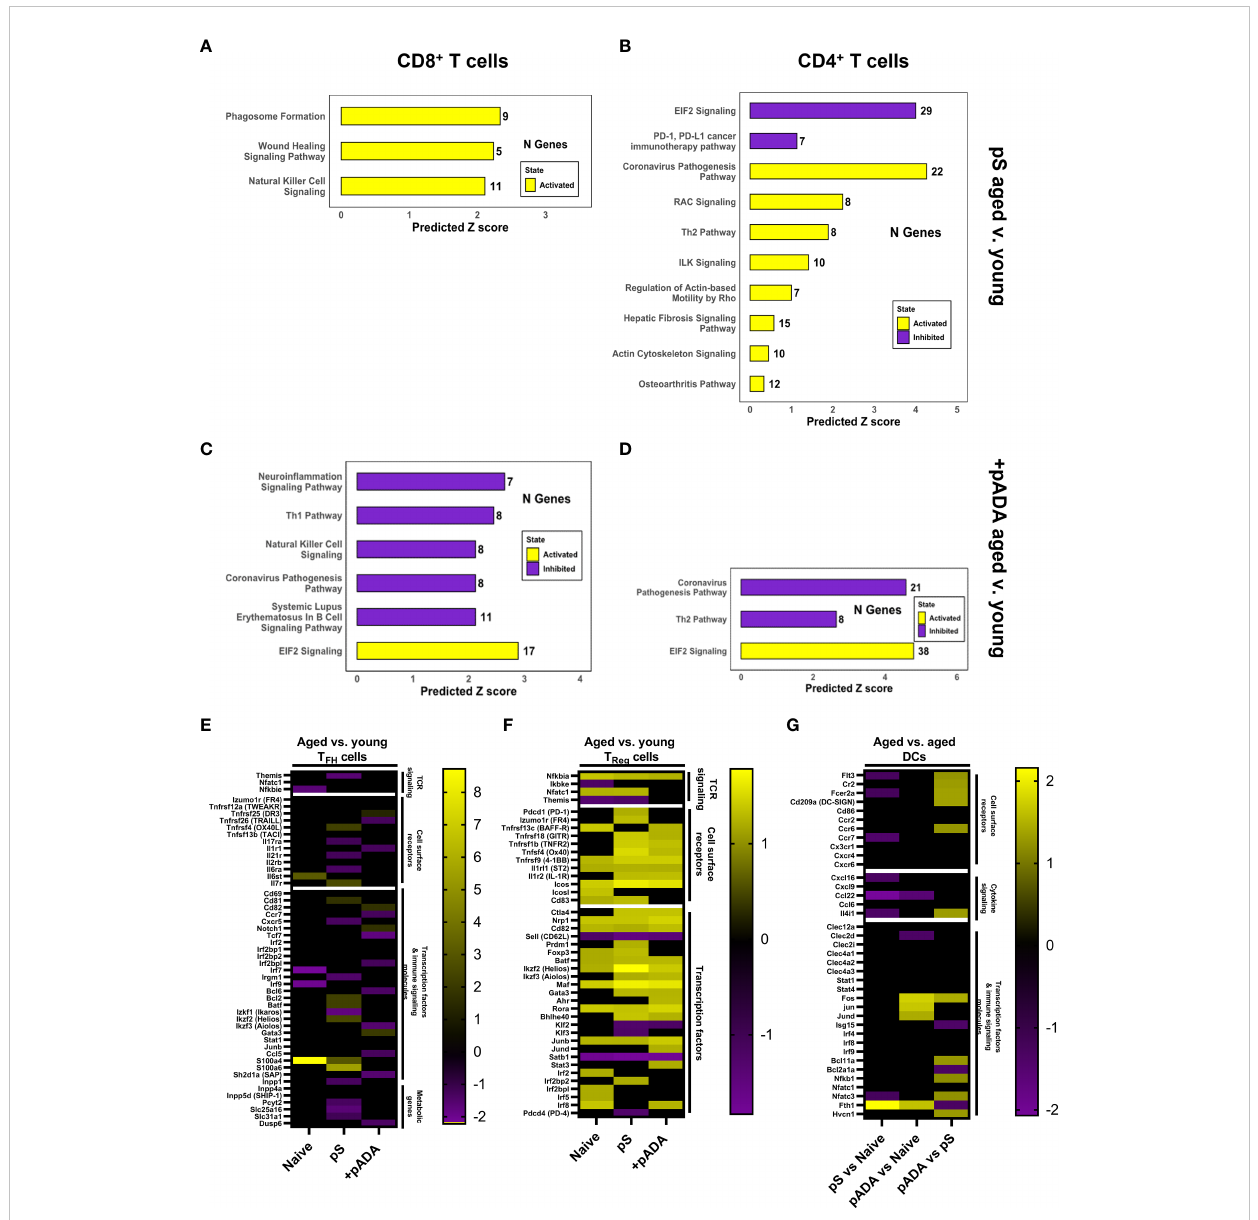
FIGURE 6 pADA co-immunization corrects age-associated increases in proin fl ammatory and pro-regulatory gene signatures. Mice were immunized twice with pS alone or co-immunized with pADA as in Figure 2 and popliteal and inguinal lymph nodes from 10 mice per immunization condition were pooled and subjected to single-cell RNA sequencing (scRNAseq) and ingenuity pathway analysis (IPA). IPA analysis of differentially regulated pathways in aged lymph nodes as compared to young lymph nodes following pS-only immunization among CD8 + T cells (A) and CD4 + T cells (B) . IPA analysis of differentially regulated pathways in aged lymph nodes as compared to young lymph nodes following pS and pADA co-immunization among CD8 + T cells (C) and CD4 + T cells (D) . (E) Select differentially expressed genes in aged animals compared to young animals among follicular helper T (T FH ) cells. (F) Select differentially expressed genes in aged animals compared to young animals among T regulatory (T Reg ) cells. (G) Select differentially expressed genes in the dendritic cell (DC) compartment of aged animals among immunization